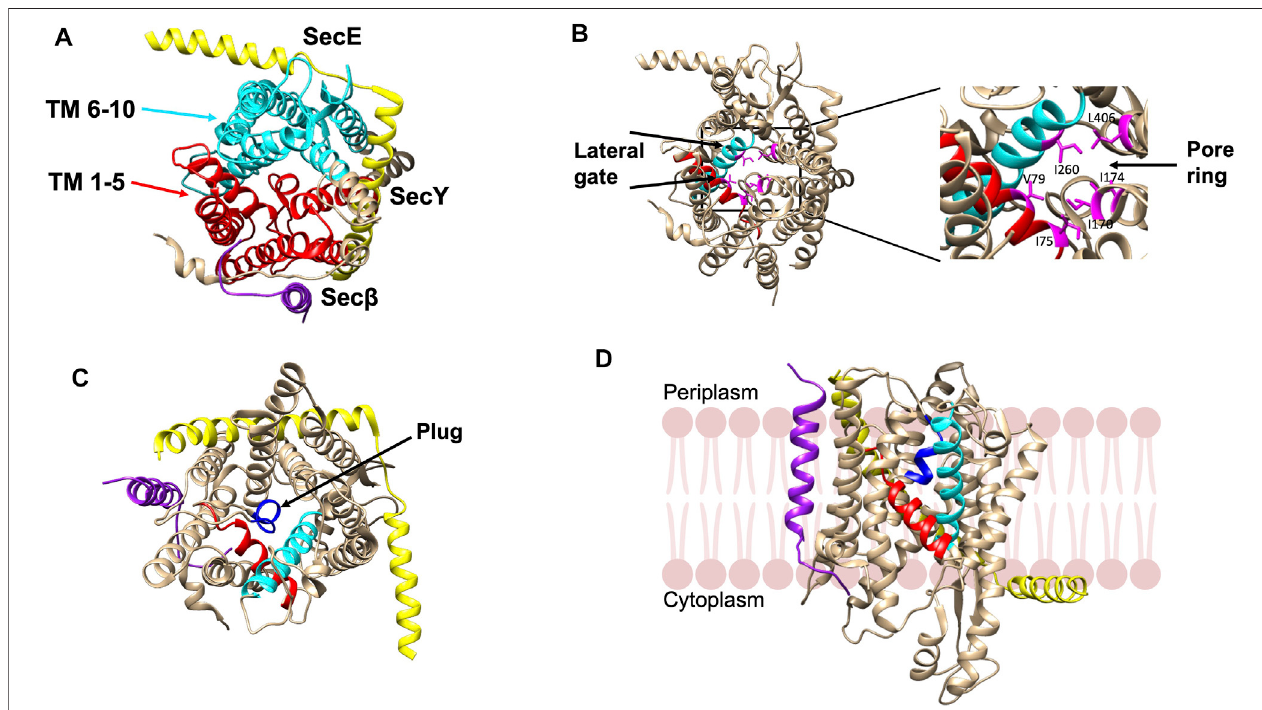
FIGURE 4 | Crystal structure of the SecYE β complex in the resting state from Methanocaldococcus jannaschii [adapted from van den Berg et al. (2004) PDB: 1RHZ] (A) . TM1-5 (red) and TM6-10 (cyan) are the halves of SecY. SecE and Sec61 β are in yellow and purple, respectively. (B) The pore ring comprised of six residues (pink)andlateralgate(TM2binredandTM7incyan)arehighlighted. (C) Theplughelixlocatedabovetheporeringisindicatedindarkblue. (D) TheSecYE β complexfrom Thermus thermophiles (PDB: 5AWW). The lateral gate region comprised of TM2b (red) and TM7 (blue) is the site where the signal peptide or TM segments of membrane proteins exit the channel upon opening of the gate. The SecYE β structures in (A – C) are shown perpendicular to the membrane.